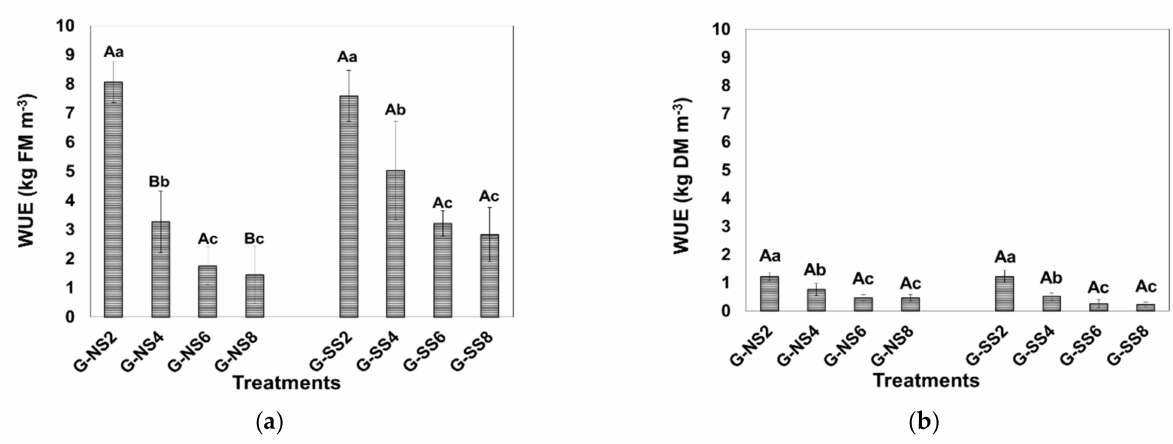
Figure 6. Water use efficiency (WUE, kg m − 3 ) based on the ( a ) fresh matter (FM) and ( b ) dry matter (DM) of basil crops during the first experimental period. Lowercase letters indicate the differences between salinity regimes, whilst uppercase letters show the differences amongst G-NS and G-SS treatments for the same salinity regime. Means followed by the different letters differ significantly across treatments according to the Tukey–Kramer HSD test at p < 0.05.